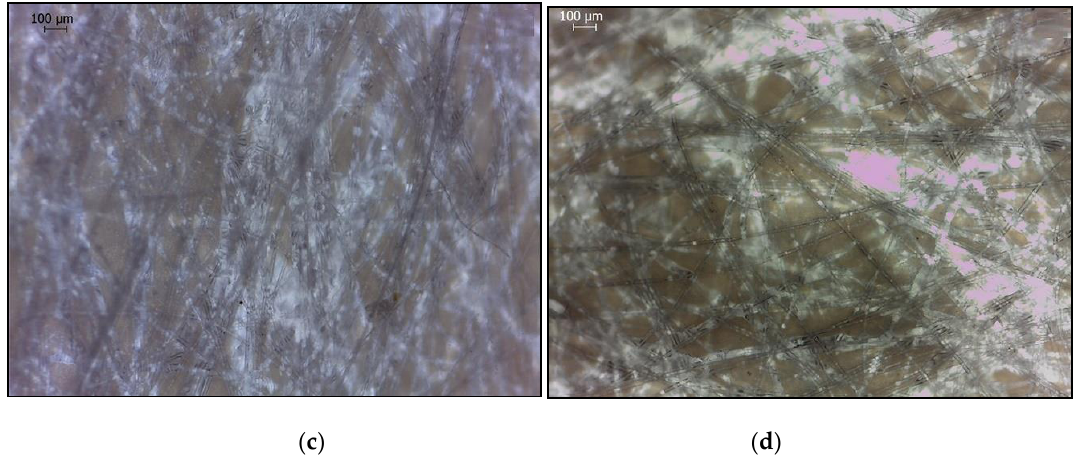
Figure 8. Optical microscope images of the membrane: ( a ) active layer before scaling; ( b ) active layer after scaling; ( c ) support layer before scaling; and ( d ) support layer after scaling. Scaling conditions: concentrations of NaCl, CaCl 2 , and Na 2 SO 4 are 1.754, 6.132, and 4.487 g / L, respectively; SI = 2.45; 12.5 cm / s cross-flow velocity; the feed and draw solutions were circulated counter-currently; and an AL-FS orientation.